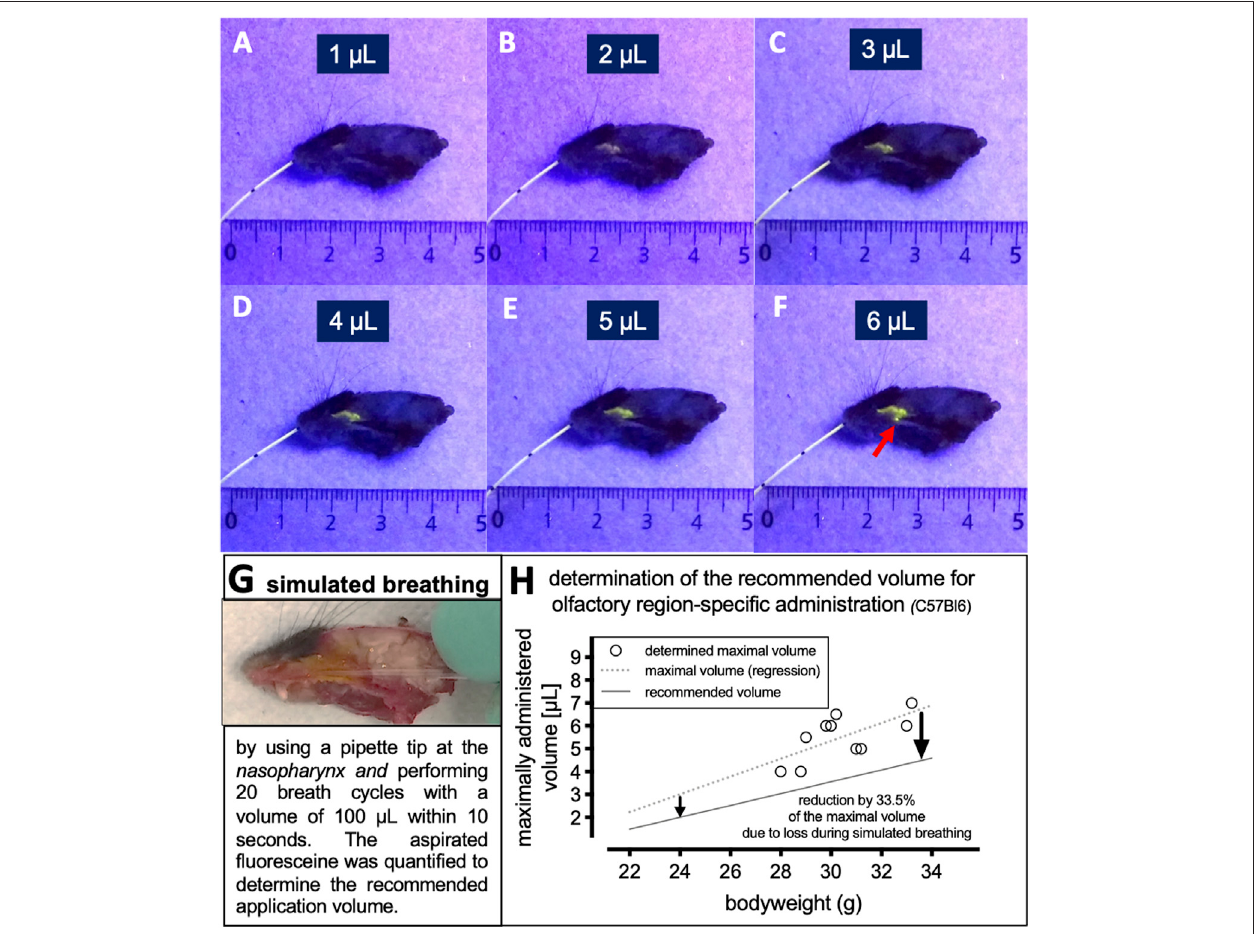
FIGURE 3 | Determination of maximum volume to target the olfactory mucosa in C57Bl6 mice. (A – E) The parts lateral from the nasal septum had been removed carefullytogiveaccess totheolfactoryregion.Thecatheter wasinserted totargettheolfactoryregionanda fl uorescein solutionwasappliedinstepsof0.5 µLunderUV illumination. (F) The maximum volume was determined when the fl uorescein solution drained into the nasal passage as indicated with the arrowhead. This occurred duringtheincreaseofappliedvolumefrom5.5to6 µL.Thus,themaximumvolumeforolfactoryregion-speci fi ctargetingwasdeterminedas5 µL. (G) Insertionofa 10 µlpipettetipintothenasopharyngealductofthemurineskulltosimulatethemurinebreathingpatternwithinhalationandexhalation.20simulatedbreathcycleswitha volume of 100 µL each were performed within 10 s. The volume of fl uorescein sodium that remained in the pipette after the last inhalation was quanti fi ed and denominatedastheaspiratedvolume. (H) Determinationofthedependency oftheexperimentallydeterminedmaximumvolumeand therecommendedvolumewiththe weightoftheindividualmousecadavers.Thewasasigni fi cantcorrelationbetweenexperimentallydeterminedvolumesandindividualweight(* p < 0.04, r 2 (cid:1) 0.43, n (cid:1) 10).